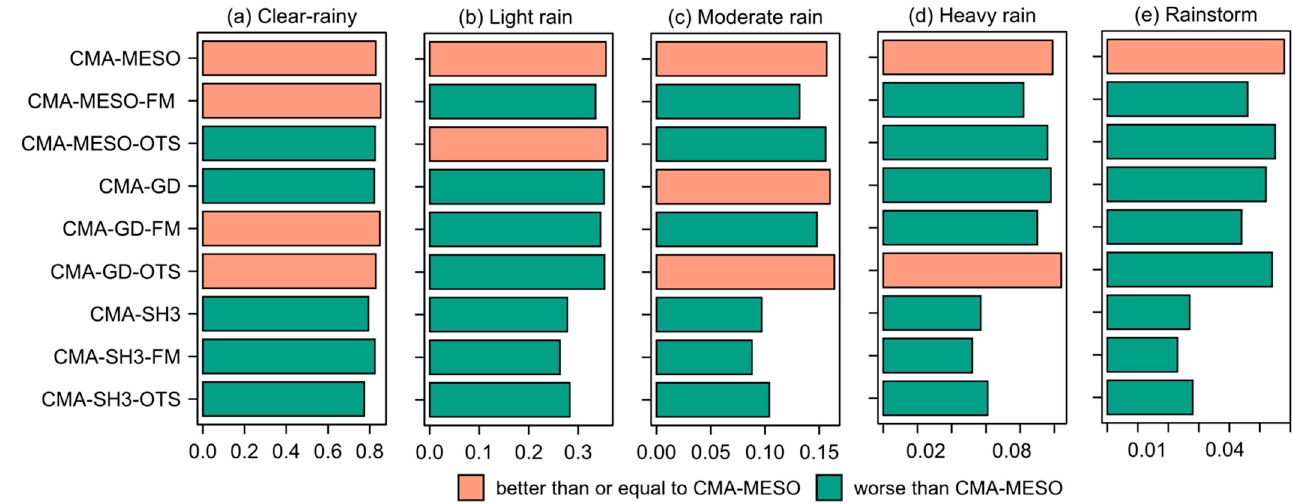
Figure 5. Threat score of ensemble members. The details of each member are shown in Table 2.